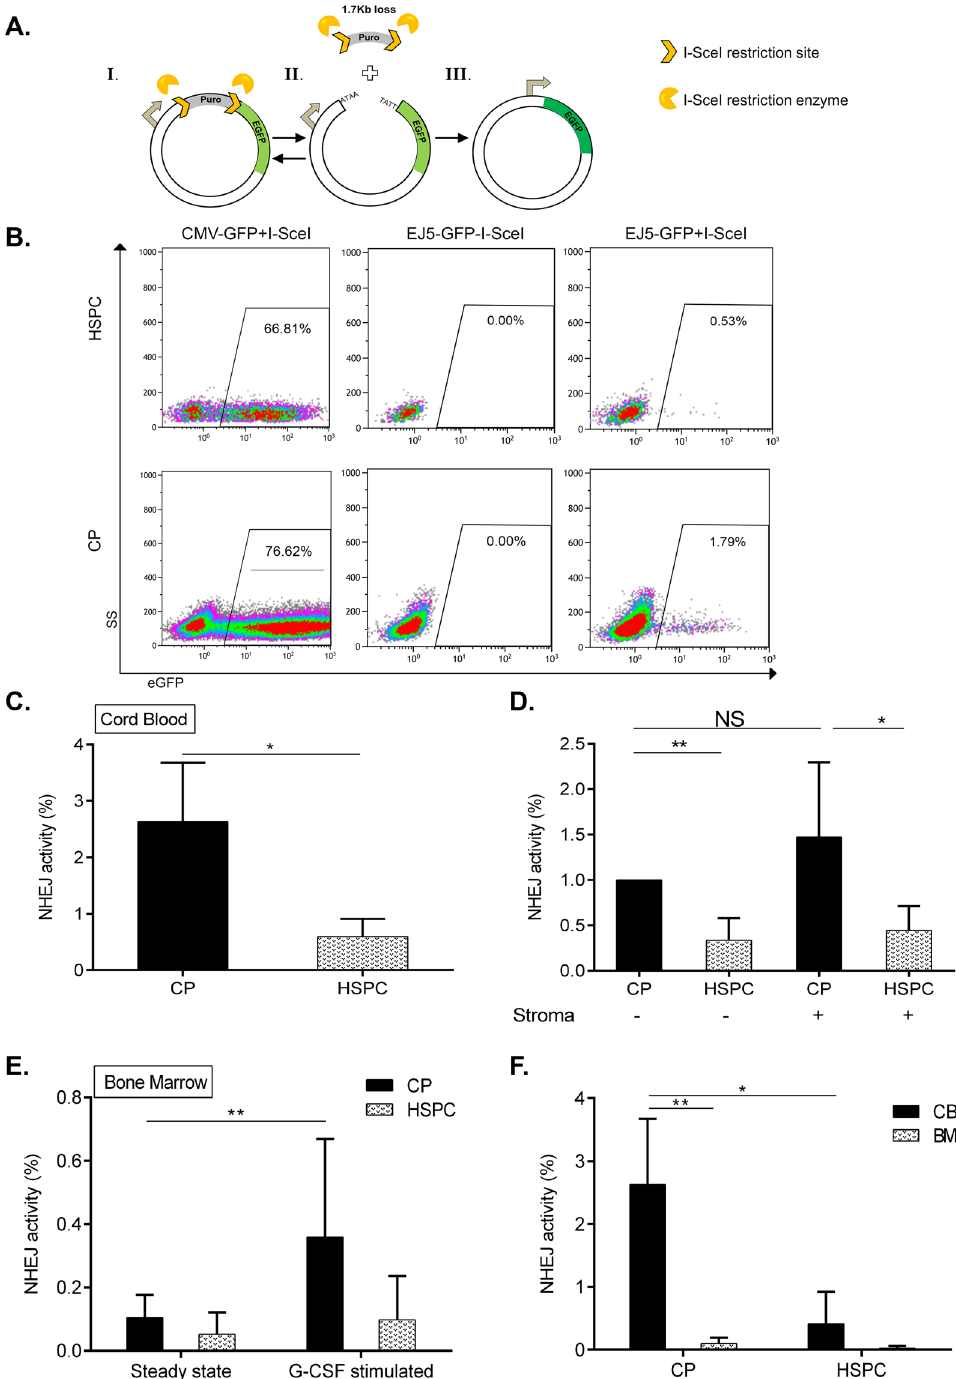
Figure 3. Analysis of DSB repair via NHEJ in CPs and HSPCs using a reporter system. (A) Schematic presentation of DSB repair substrate EJ5-GFP (I.) and I- Sce I endonuclease-mediated cleavage (II.), triggering NHEJ processes which restore the EGFP expression cassette (III.). (B) Representative flow charts of NHEJ activity and nucleofection efficiency in HSPCs and CPs. Freshly isolated CD34 + cells from cord blood were nucleofected with plasmid CMV-GFP (positive control for EGFP expression) or EJ5-GFP reporter with or without I- Sce I endonuclease expression plasmid and cultured for 24 h. Then, the proportion of viable EGFP + cells in HSPC- and CP- fractions gated as described in Fig. 1A was analyzed by flow cytometry. (C) NHEJ capacity of CP- and HSPC- enriched fractions isolated from cord blood (n = 3). (D) Nucleofected CD34 + cells from cord blood were plated in wells containing medium only or stroma layers for 24 hrs, followed by NHEJ capacity assessment in CP- and HSPC- enriched fractions. (E) Human bone marrow samples obtained from G-CSF treated (10 ug/kg for 5 days prior to harvesting) (n = 2) or steady-state control donors (n = 4) were nucleofected and processed for NHEJ activity assessment as described in Fig. 1B. NHEJ